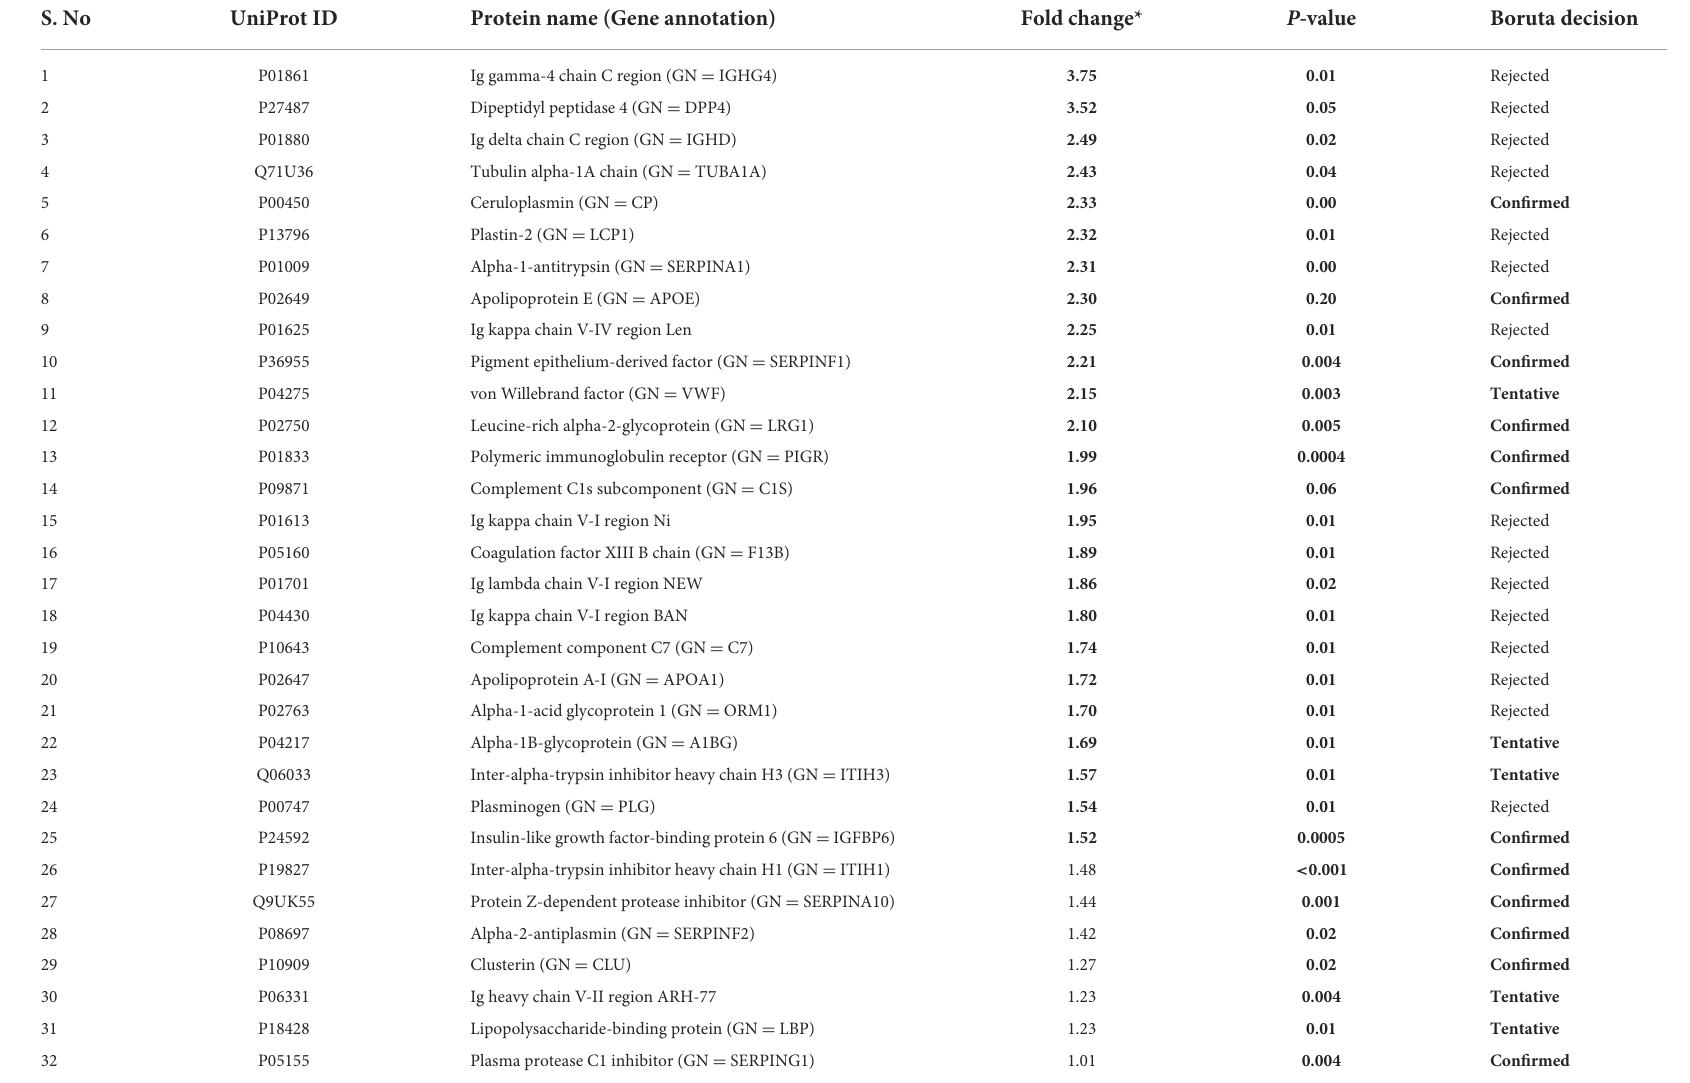
TABLE 4 List of significantly differentially expressed proteins between intracerebral hemorrhage and healthy controls using fold change with p- value and Boruta random forest feature selection criteria. S. No UniProt ID Protein name (Gene annotation) Fold change* P- value Boruta